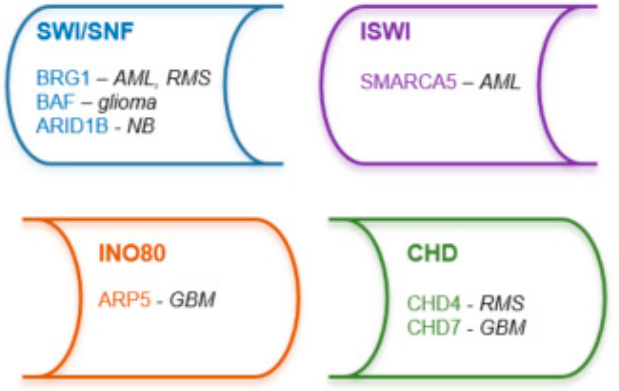
Figure 3. Targetable components of nucleosome remodeling complexes in pediatric malignancies (see references in the text). Abbreviations of diseases: AML: acute myeloid leukemia, GBM: glioblastoma multiforme, NB: neuroblastoma, RMS: rhabdomyosarcoma. Dual inhibitors of SWI/SNF catalytic subunits, BRM (SMARCA2) and BRG1 (SMARCA4) lead to downregulation of leukemic pathway genes, including MYC in AML